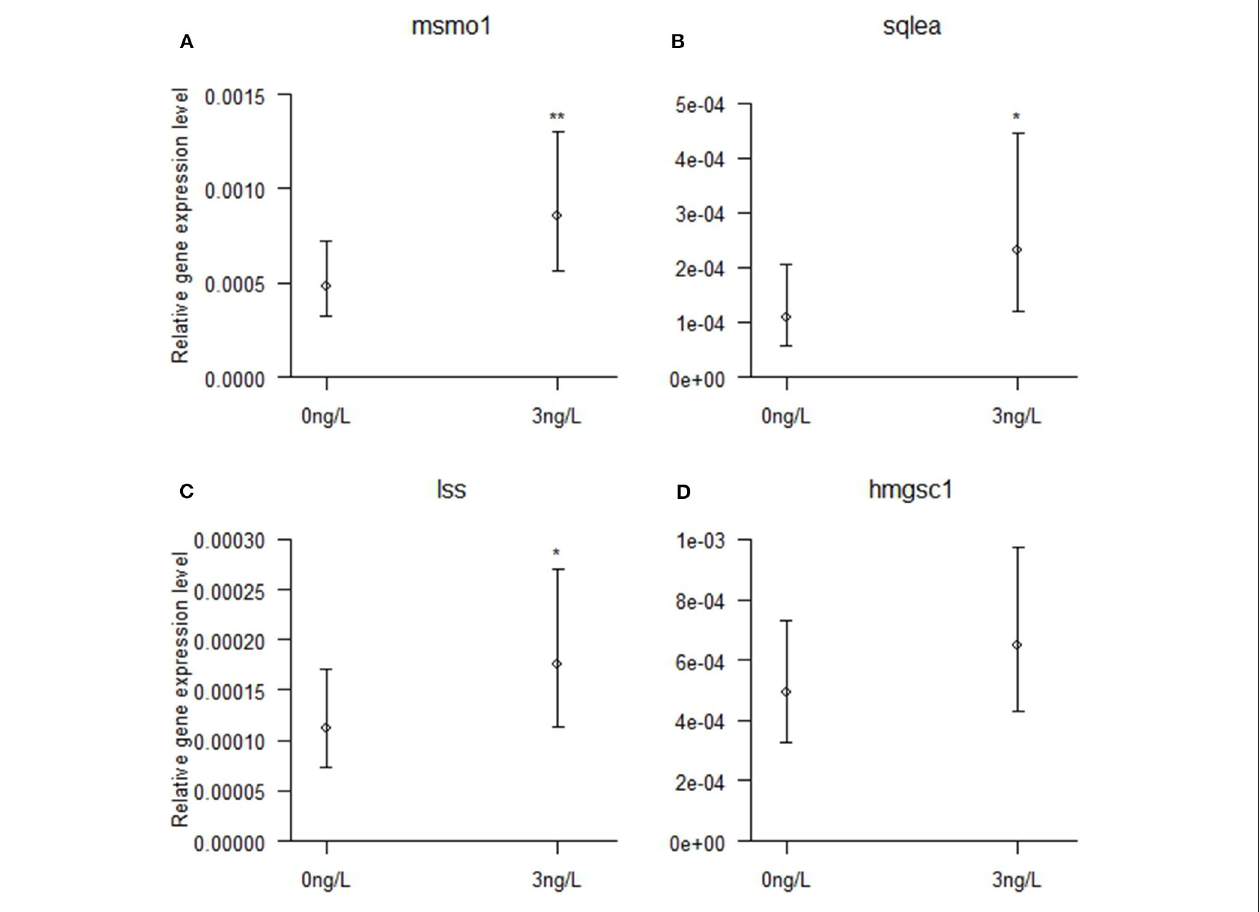
FIGURE 4 | Brain mRNA expression of (A) msmo1 , (B) sqlea , (C) lss, and (D) hmgcs1 in zebrafish males developmentally exposed to 0 or 3ng/L EE 2 and remediated in clean water for 120 days. The mRNA expression was quantified with qPCR and normalized against the expression of 18S RNA and Elf1a , displaying the relative gene expression. Data represent mean ± 95% CI of 10 samples/group, * p < 0.05, ** p < 0.01. * Significantly different from control